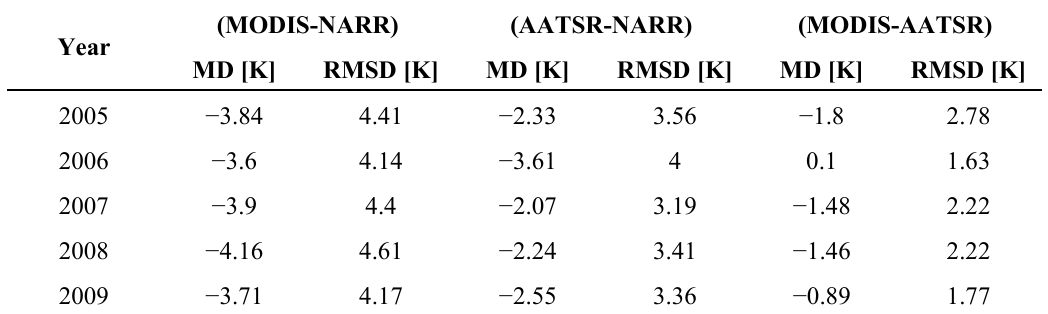
Table 5. Difference between mean annual surface temperature (MAST) estimated from monthly UW-L3 of MODIS and AATSR LST, and NARR 0-m surface temperature over North